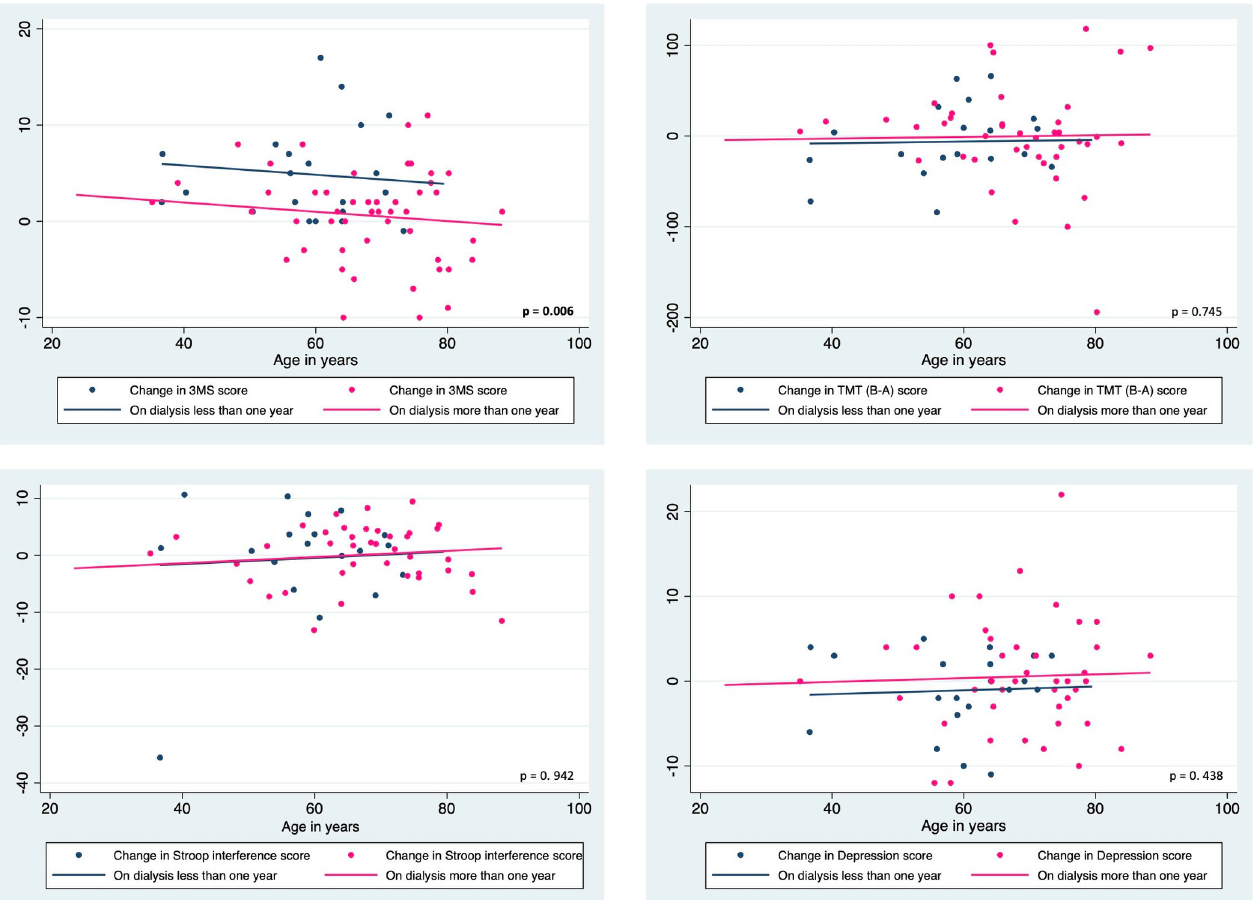
Fig 4. Change scores of cognitive function and depression in ESKD patients with dialysis vintage < 1-year and > 1-year with fitted regression lines from ANCOVA models using age as a continuous covariate.